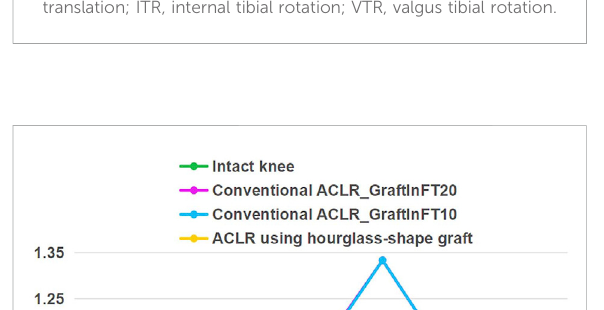
FIGURE 5 Comparison of a conventional columnar graft to an hourglass-shaped graft for restoring knee stability and ligament force. The values were standardized against an intact knee.